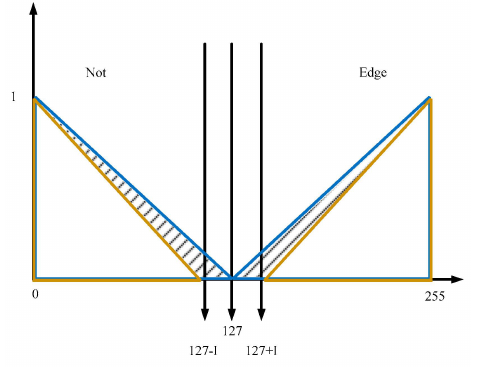
Figure 11. Output Fuzzy